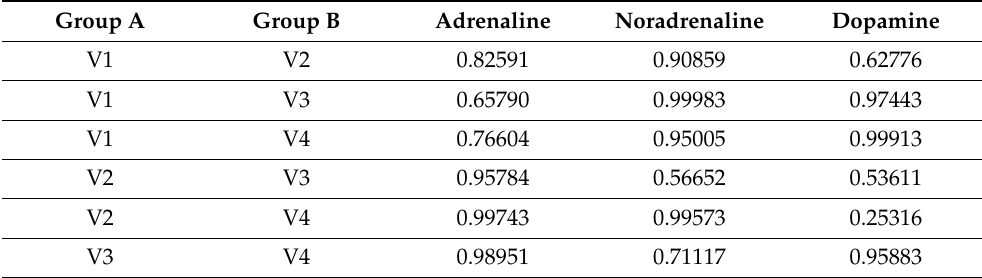
Table 6. p -values results from Kruskal-Wallis one-way ANOVA test for catecholamine concentration data grouped by video